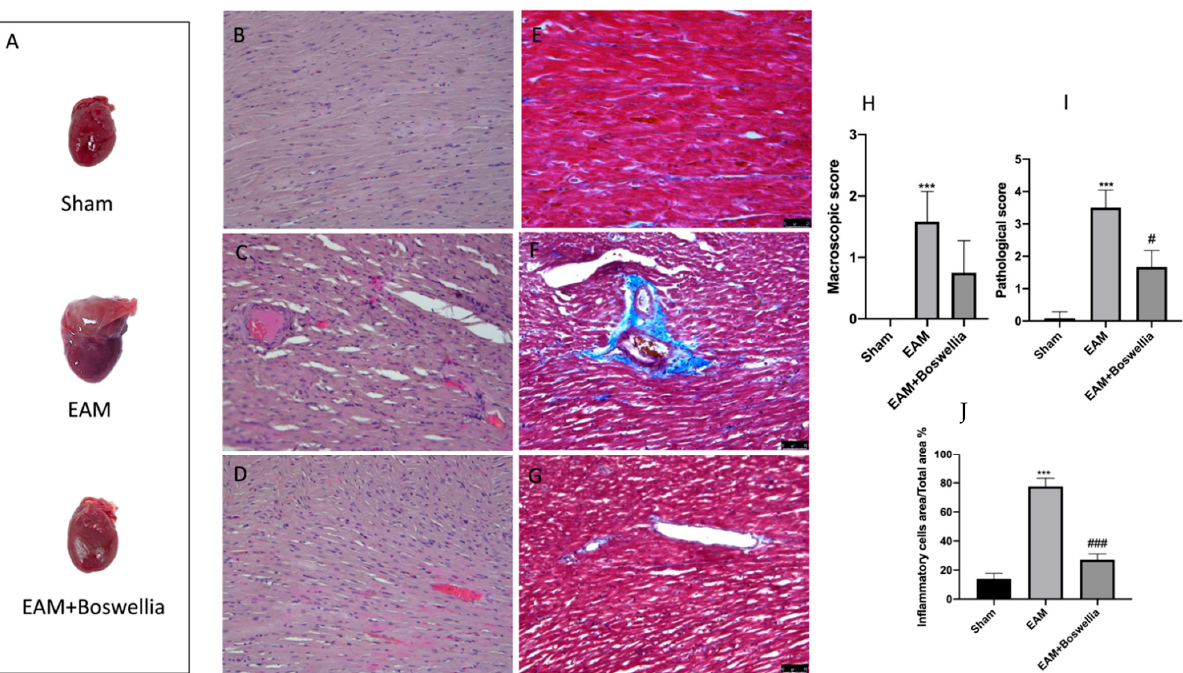
Figure 3. Effect of Boswellia extract on macroscopic and microscopic scores. Macroscopic panel ( A ), Histological and Masson stainings were evaluated in heart tissues of sham ( B , E ), EAM + vehicle ( C , F ) EAM + Boswellia gum extract ( D , G ). Macroscopic and microscopic scores were shown ( H , I ). Percentage of Inflammatory cells area/total area ( J ). Boswellia extract administration was able to reduce macroscopic and microscopic scores and inflammatory infiltrate. Values = means ± SEM of 6 animals for each set. *** p < 0.001 vs. sham; ### p < 0.001 vs. EAM. # p < 0.05 vs. EAM.